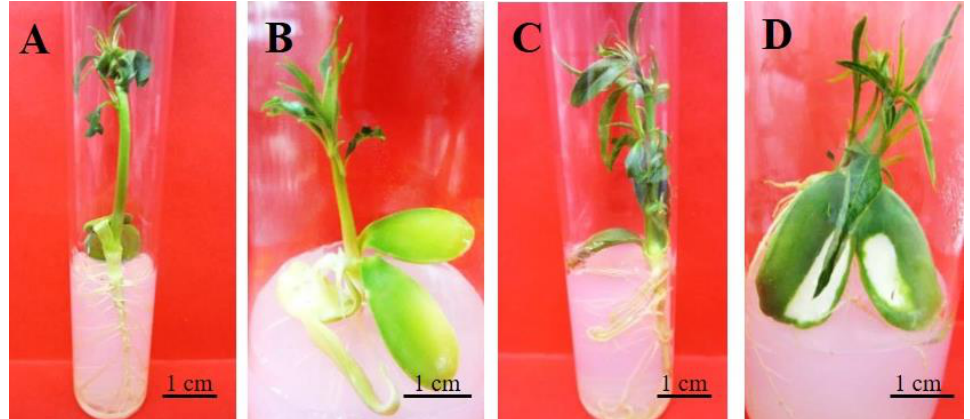
Table 3. Effect of the culture media, different plant growth regulators and their concentrations on the shoot formation per explant from the nodal segments of four hybrids of the peach.